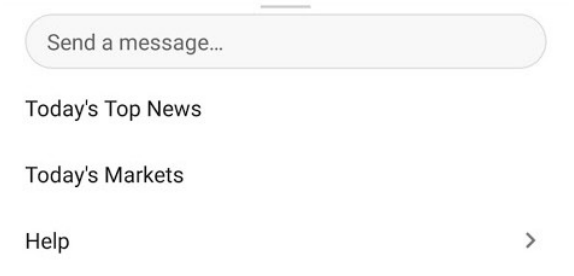
Fig. 14. WSJ’s persistent menu on messenger app on January